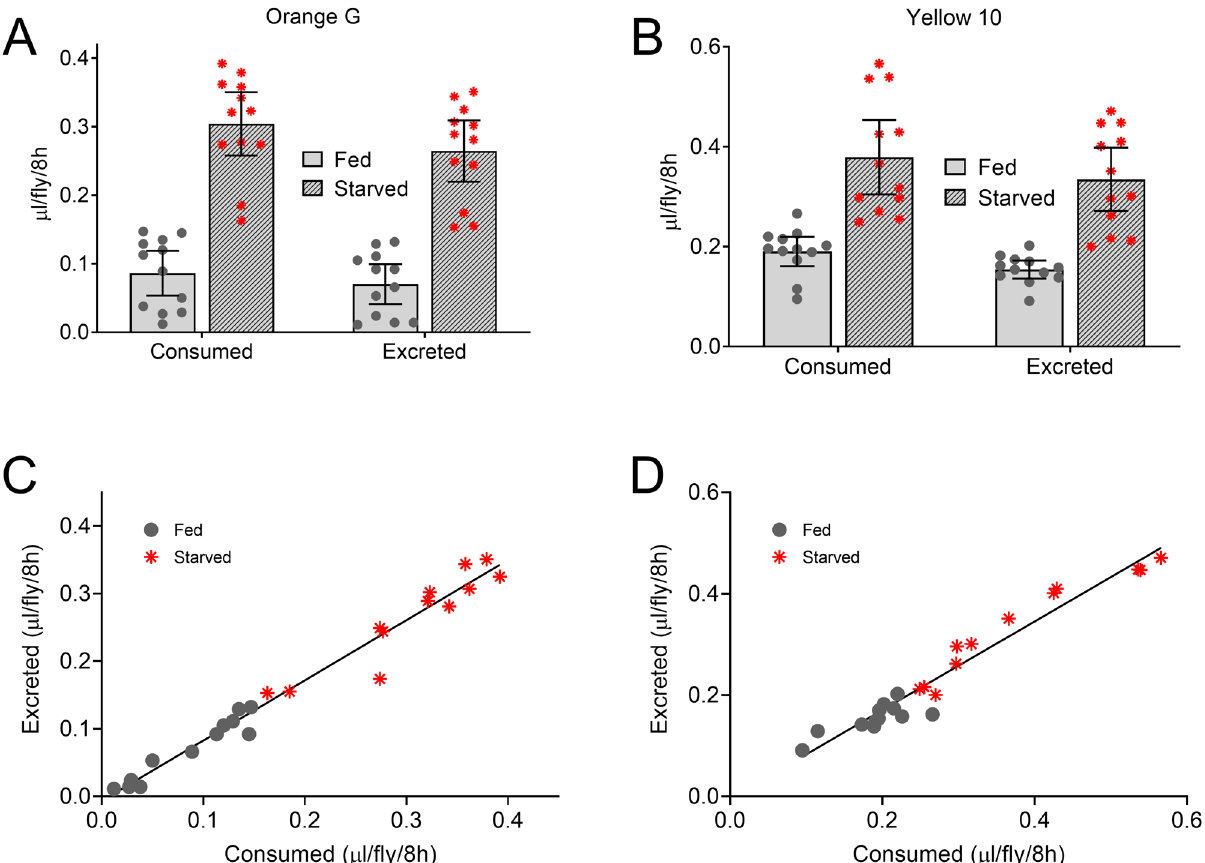
Figure 7. Coupled CAFE:Con-Ex studies with Orange G and Yellow 10. ( A , B ) Starvation, but not the method used to measure dye volume (i.e. CAFE consumed vs ExVial excreted), affected the volume of media determined with Orange G ( A ) and Yellow 10 ( B ) (individual two-way ANOVAs; starvation, p < 0.0001; consumed vs excreted, p = 0.0951 to 0.1238; n = 12). ( C , D ) The volume of media consumed via CAFE correlated with the volume of dye excreted via Con-Ex determined with Orange G ( C ) and Yellow 10 ( D ) (Pearson; Orange G, R 2 = 0.9771, p < 0.0001; Yellow 10, R 2 = 0.9472, p <